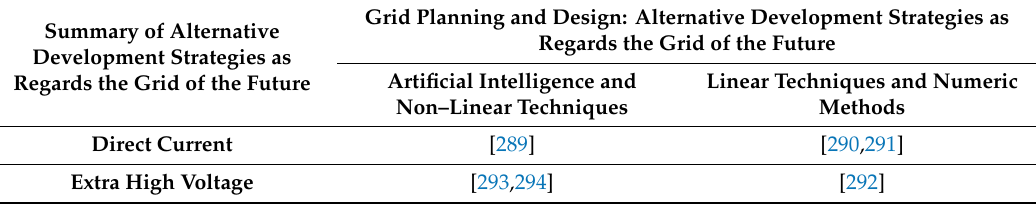
Table 14. Summary of Alternative Development Strategies as Regards the Grid of the